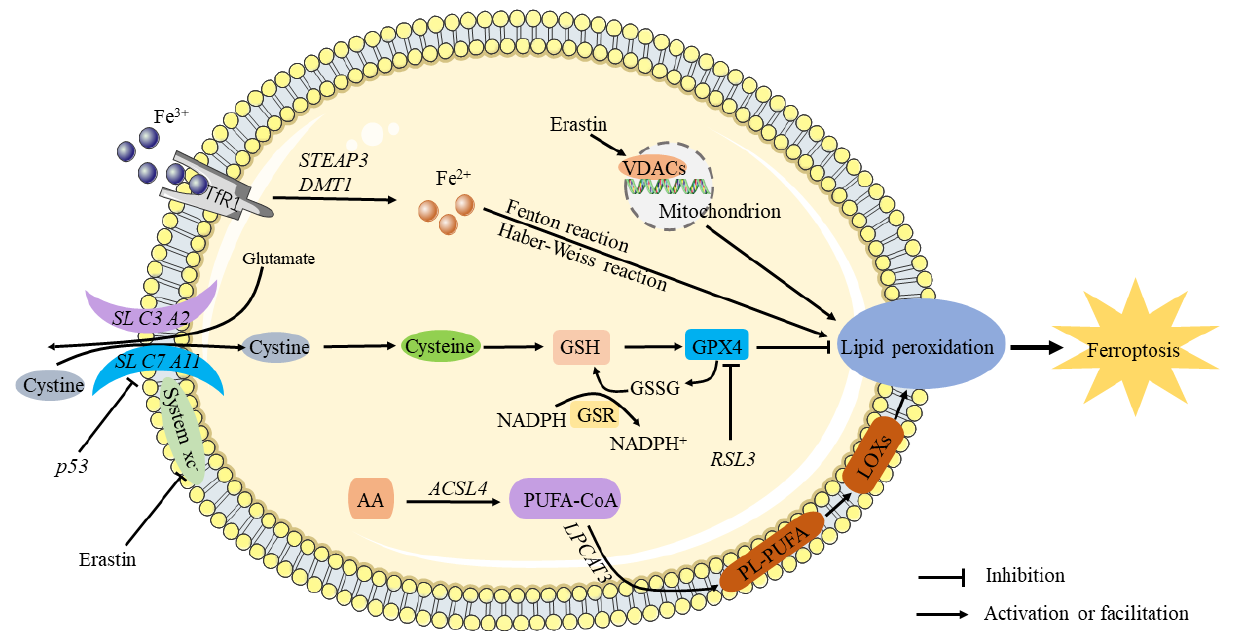
Figure 1. The mechanism of ferroptosis. It is known that circulating iron enters cells by binding to the TfR1 on the cell membrane, where STEAP3 reduces ferric iron into ferrous iron. The Fenton and Haber–Weiss reactions produce ROS when divalent iron is released by DMT1 to a labile pool of iron in the cytoplasm, thereby triggering ferroptosis. Extracellular cystine is transported into the cell and converted into cysteine by the sodium-dependent system xc–. Inhibiting system Xc- decreases GSH levels in cells, aggravating ROS accumulation and ultimately causing ferroptosis. Through downregulation of the SLC7A11 subunit, P53 inhibits the uptake of cystine by system X, resulting in decreased cystine-dependent glutathione peroxidase activity and cell antioxidant capacity and an increase in lipid ROS, leading to ferroptosis. By antagonizing GPX4, RSL3 induces ferroptosis. As a result of chain reactions, hydroxyl radicals can directly react with PUFAs in membrane phospholipids to form lipid peroxides, causing ferroptosis.